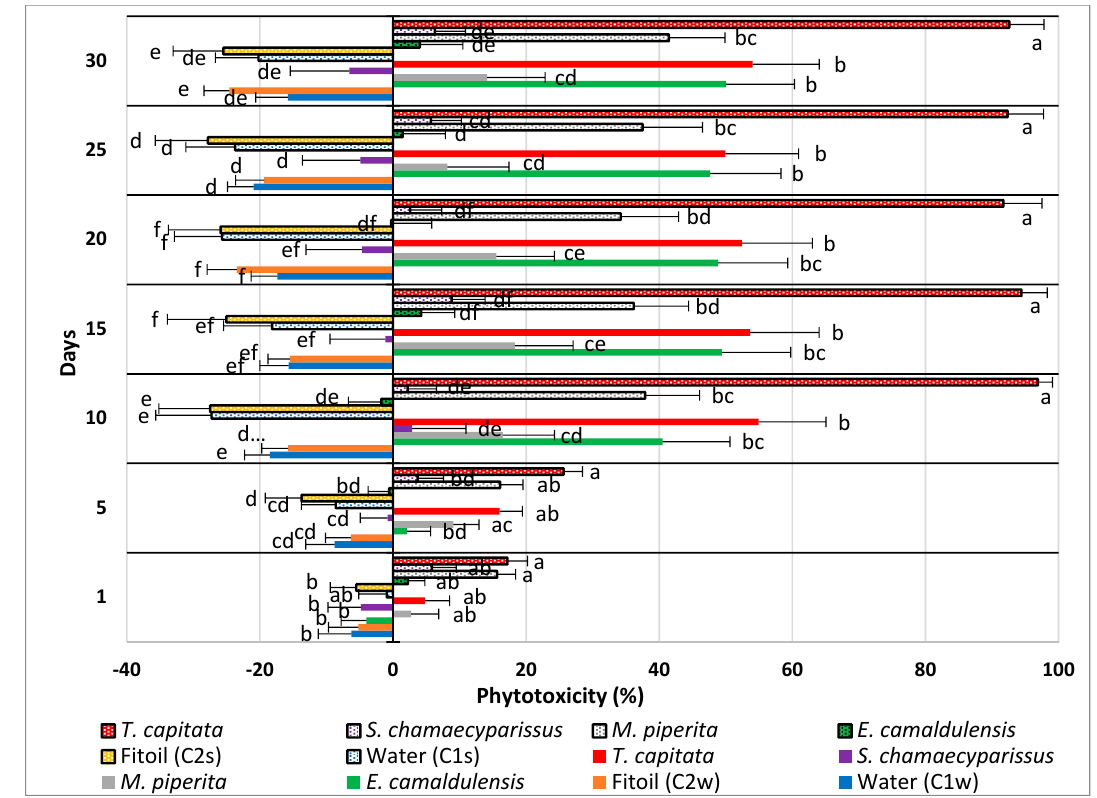
Figure 3. Calculated phytotoxicity level (%) of 4 EOs, distributed by spraying (spotted bars) and watering (full-colored bars) on seedlings of Erigeron bonariensis . Error bars indicate the standard error of each mean. For each survey date, values accompanied by the same letter are significantly not different (Tukey’s test, P ≤ 0.05).